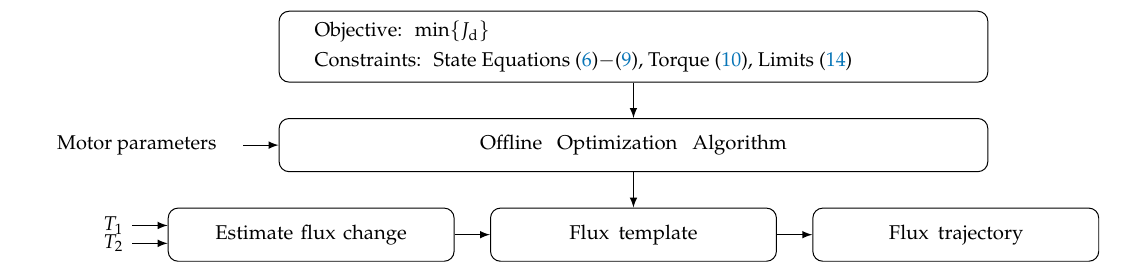
Figure 6. Flux template generation procedure.